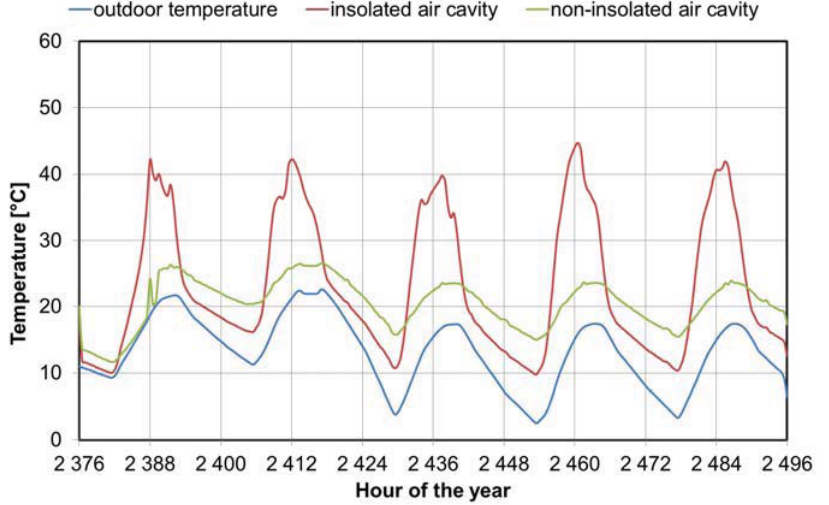
Figure 5: Air collector with the solar absorber containing the